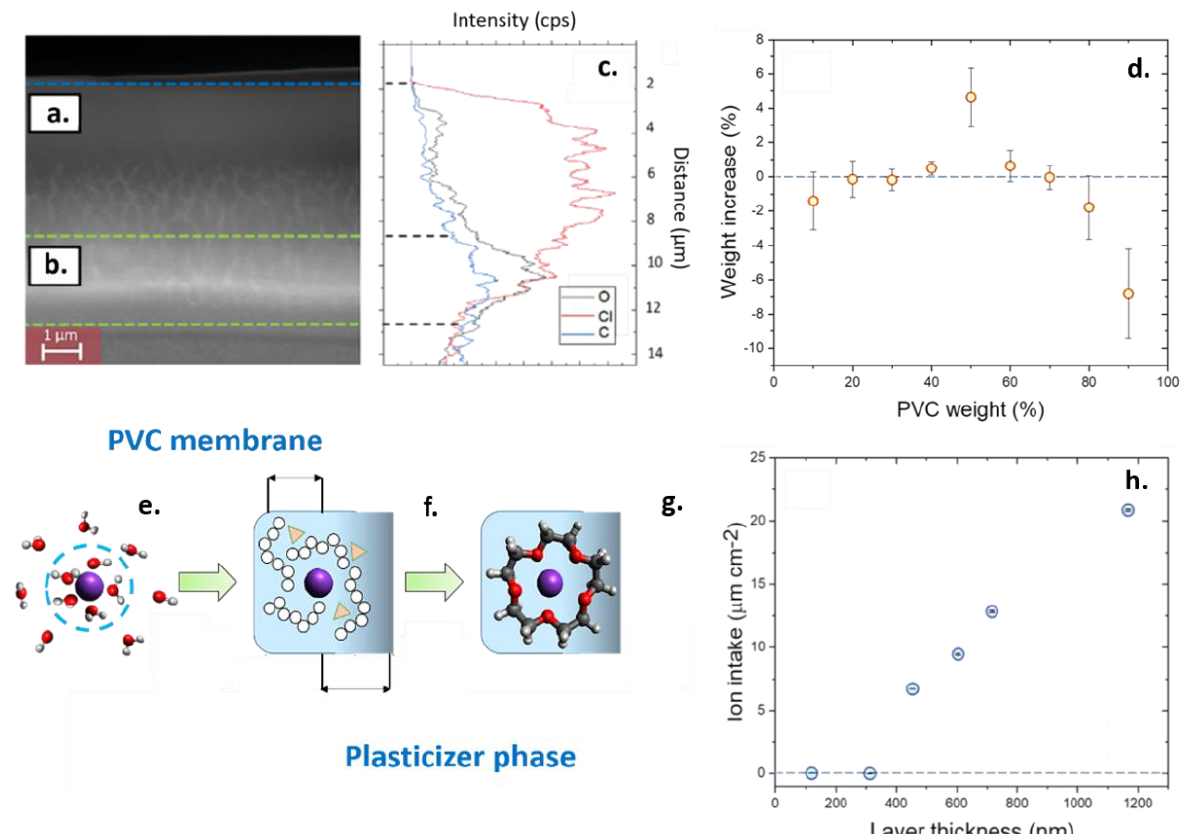
Figure 4. ( a ). Scanning electron microscopy (SEM) imaging of the plasticized polymer films, evidencing a non-homogeneous distribution of the plasticizer and the PVC. The superficial zone in direct contact to the aqueous sample showed a higher presence of PVC chains and a low plasticization. ( b ). Within the bulk phase of the ion sensing films, there was a higher presence of plasticizer and striations, indicative of the porosity of the films. ( c ). Energy-dispersive X-ray spectroscopy (EDS) linear scan of the composition of the sensing films, indicating the relative presence of oxygen, carbon and chlorine. ( d ). Quartz microbalance study of the absorption of water in the PVC films containing different amount of plasticizers. ( e ). Schematic representation of the three-step recognition process. The ions in solution are surrounded by a water shell, increasing their size. ( f ). the first step in the sensing process is the diffusion of the ions inside the membrane through the spacing created between the polymers and plasticizer. ( g ). The complexation with the ionophore process takes place. ( h ). Ion absorption properties of polymeric membranes at different thicknesses. The error bars represents 5 times the standard deviation of 1000 data points of the quartz microbalance measurements, and were in the range of 5% of the signal measurement.